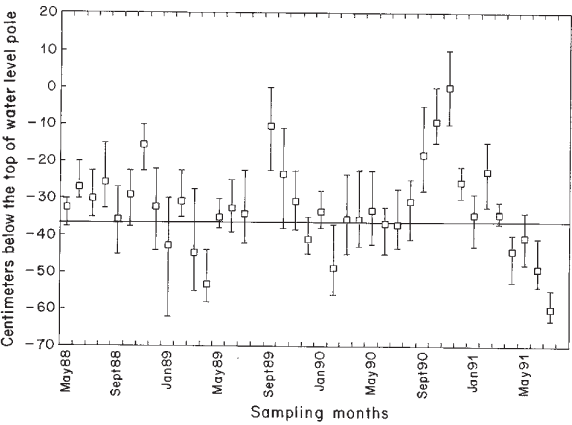
F IG . 3. – Sea level variations (in cm from the top of the pole) meas- ured in Buchuaco (Venezuela). Thick horizontal line marks the sea level at which the bottom begins to be exposed to the air. Box= mean; upper tick= maximum monthly sea level measurement; lower tick= minimum sea level